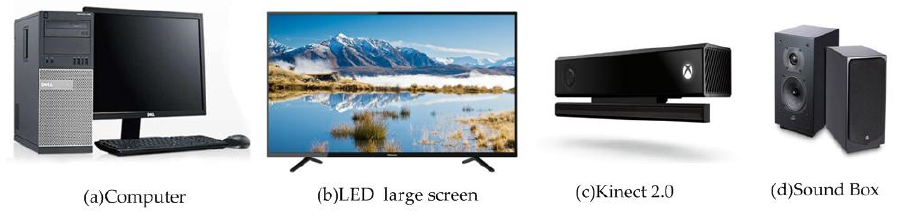
Figure 1. The hardware design of the system.